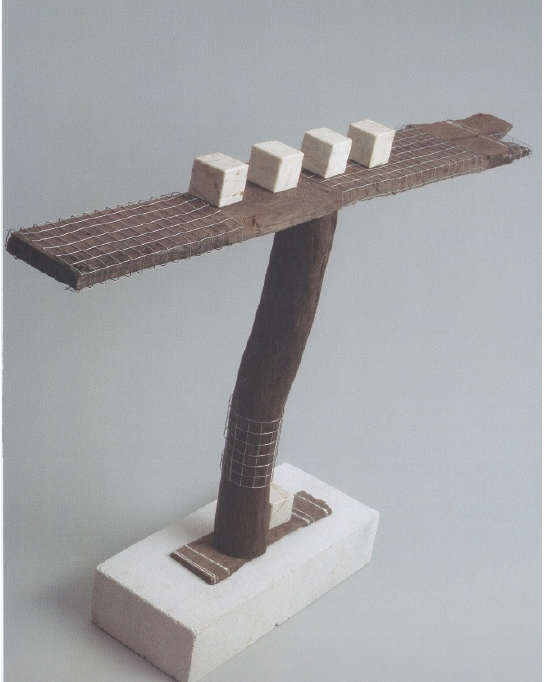
Figure 5. Leon Podsiadły, untitled, 2012, black oak, wire mesh, marble. Photograph by Stanisław Sielicki. After: (Wąs 2012a, pp. 30–31). Photo used with the permission of the artist’s family. Sielicki. After: (W ˛as 2012a, pp. 30–31). Photo used with the permission of the artist’s In the installation Alpha Yaya Diallo (2006 or the 1990s 17 ; brass, wood, stone) (Figure